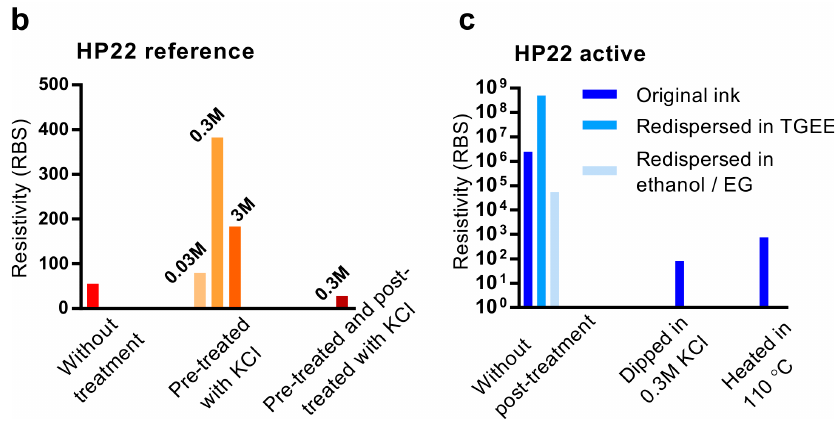
Figure 5. The impact of KCl pretreatment vs. KCl post-treatment on AgNP film resistivity, after drying in room temperature for 48 h. ( a ) Near-surface concentrations of Cl in the untreated and pretreated HP22 papers (EDS). ( b ) The impact of KCl pretreatment/post-treatment using reference papers. KCl pretreatment increased the resistivity, whereas KCl post-treatment reduced the resistivity. ( c ) The impact of the ink solvent and post-treatment using active papers. The choice of the ink solvent affected the resistivity, but it remained high for all tested solvents. Dipping the films in 0.3 M KCl at room temperature sintered the films more effectively than heating at 110 °C for 5 min. Units in RBS (resistivity of bulk silver).